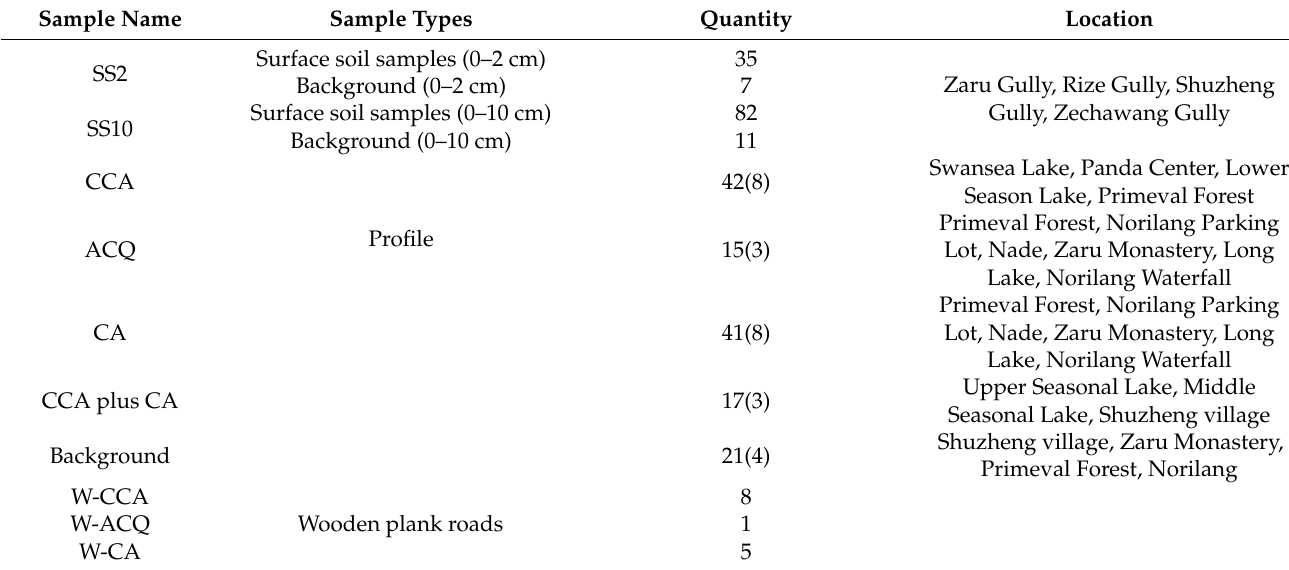
Table 1. Sampling